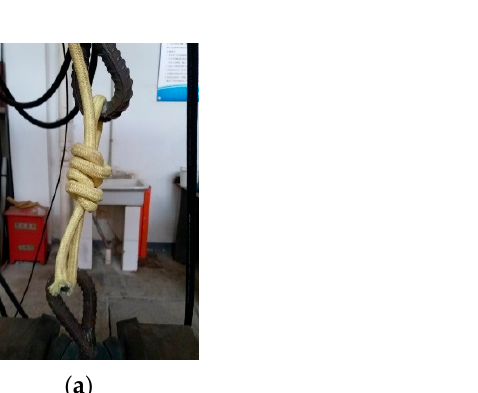
Figure 4. Knot test for binding CFR: ( a ) Picture of knot test site; ( b ) Load-displacement curve of knot test.